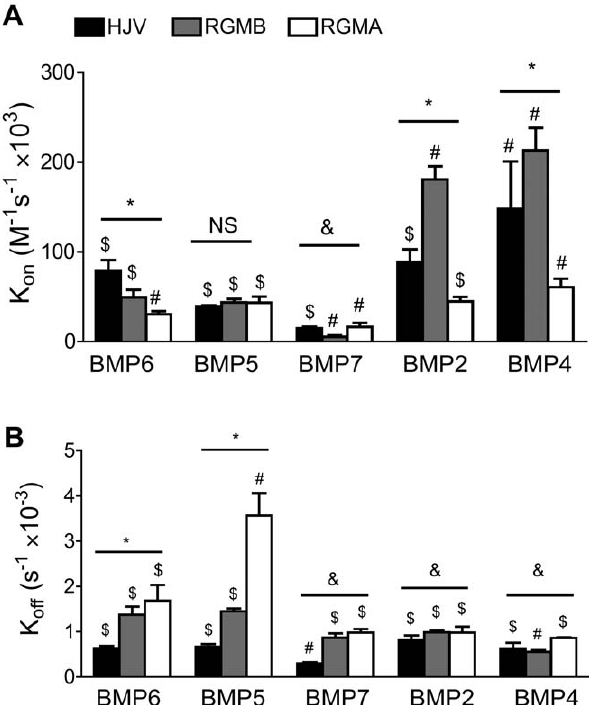
Figure 2. Association rate ( K on ) and dissociation rate ( K off ) between RGM proteins and BMP ligands. The association rate (K on , A ), and dissociation rate (K off , B ) between each RGM protein and each BMP ligand was measured by SPR and plotted as mean 6 SD (n=4– 9 per group). Black bar: HJV; gray bar: RGMB; white bar: RGMA. Statistical significance was determined as described in Figure 1. For comparisons among 3 RGM proteins for each BMP ligand: * all comparisons are significant ( P , 0.05); & not all comparisons are significant, as detailed below; NS all comparisons are not significant ( P . 0.05). For comparisons among 5 BMP ligands for each RGM protein: # all comparisons are significant ( P , 0.05); $ not all comparisons are significant, as detailed below. ( A ) $: For HJV, all pair-wise comparisons between BMP ligands are significant except for BMP2 vs BMP6, BMP5 vs BMP6, and BMP5 vs BMP7; for RGMB, all pair-wise comparisons between BMP ligands are significant except for BMP5 vs BMP6; for RGMA, all pair- wise comparisons between BMP ligands are significant except for BMP2 vs BMP5. &: For BMP7, all pairwise comparisons are significant except for HJV vs RGMA ( B ) $: For HJV, all pair-wise comparisons between BMP ligands are significant except for BMP2 vs BMP5, BMP4 vs BMP5, BMP4 vs BMP6, and BMP5 vs BMP6; for RGMB, all pair-wise comparisons between BMP ligands are significant except for BMP2 vs BMP7 and BMP5 vs BMP6; for RGMA, all pair-wise comparisons between BMP ligands are significant except for BMP2 vs BMP4, BMP2 vs BMP7, BMP4 vs BMP7, and BMP6 vs BMP7. &: For BMP7, all pairwise comparisons are significant except for RGMB vs RGMA; for BMP2, all pairwise comparisons are significant except for RGMA vs RGMB; for BMP4, all pairwise comparisons are significant except for RGMB vs HJV.